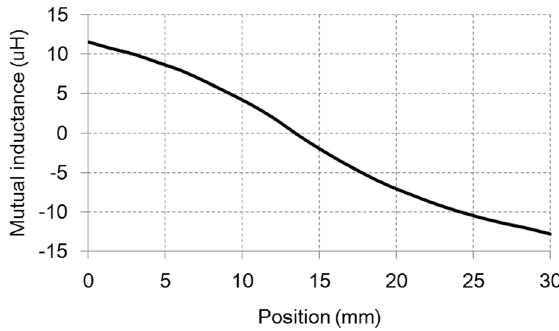
Figure 21. The mutual inductance value of the windings of the linear direction and the windings responsible of the rotation.